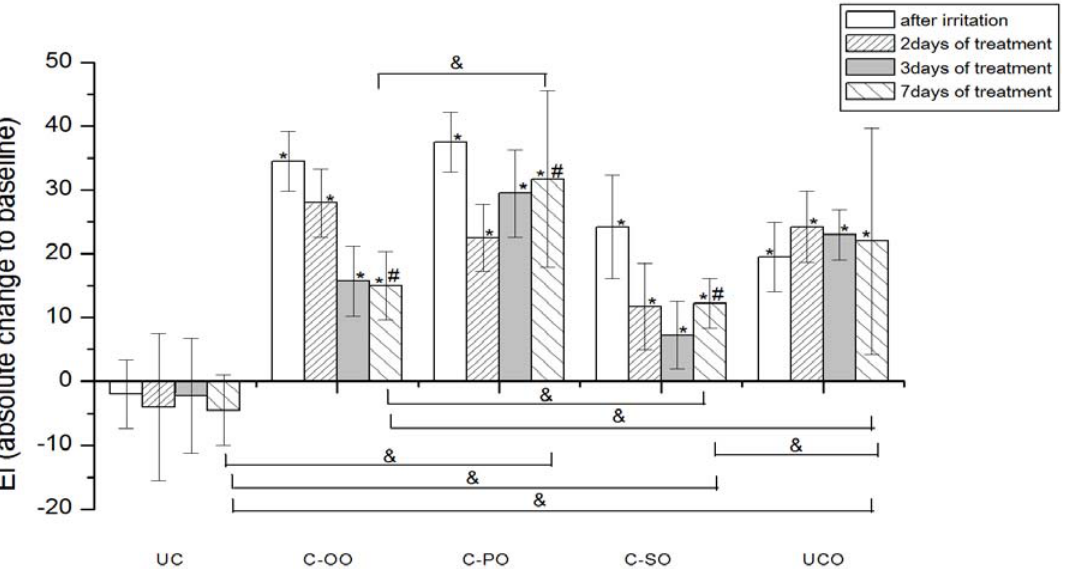
Figure 4. The influence of the irritation per se and samples C-OO, C-PO and C-SO after irritation on EI. Parameters were expressed as absolute changes to baseline at distinct time points. The effects of different formulations were compared mutually and to UC and UCO (significant differences being marked with &). Differences to corresponding sample without SJW (C-OO, C-PO and C-SO) were checked only on day 7, significant differences being marked with (#). (*) is for significant difference of EI at distinct time point related to corresponding baseline (means were compared).